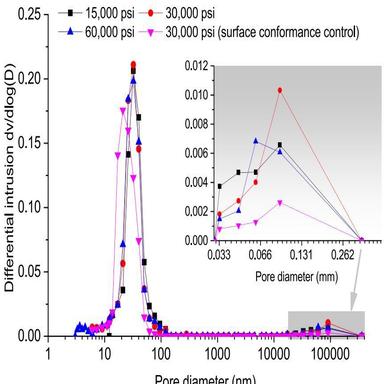
Differential TSDs of the porous cement paste samples from the intrusion branches in different maximum applied pressures and surface conformance conditions.